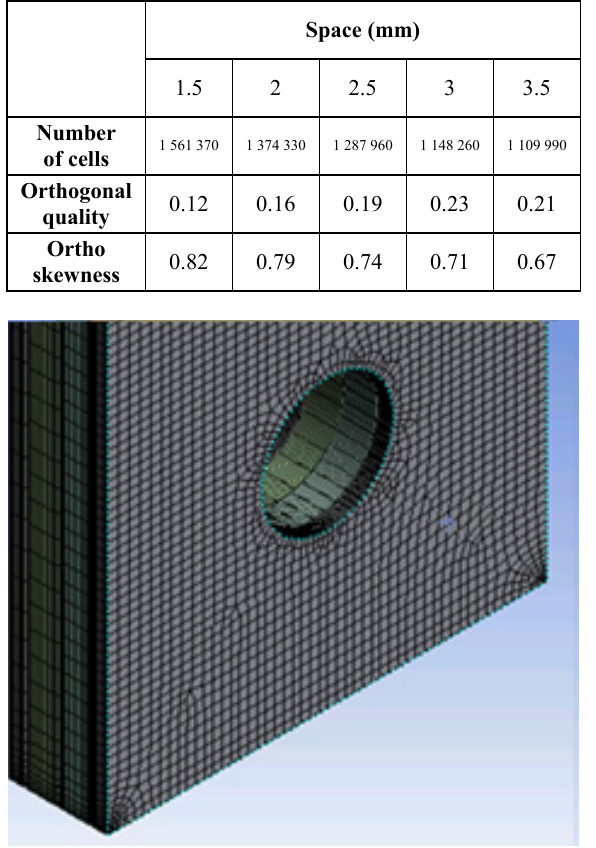
Fig. 5. Characteristics of fan.